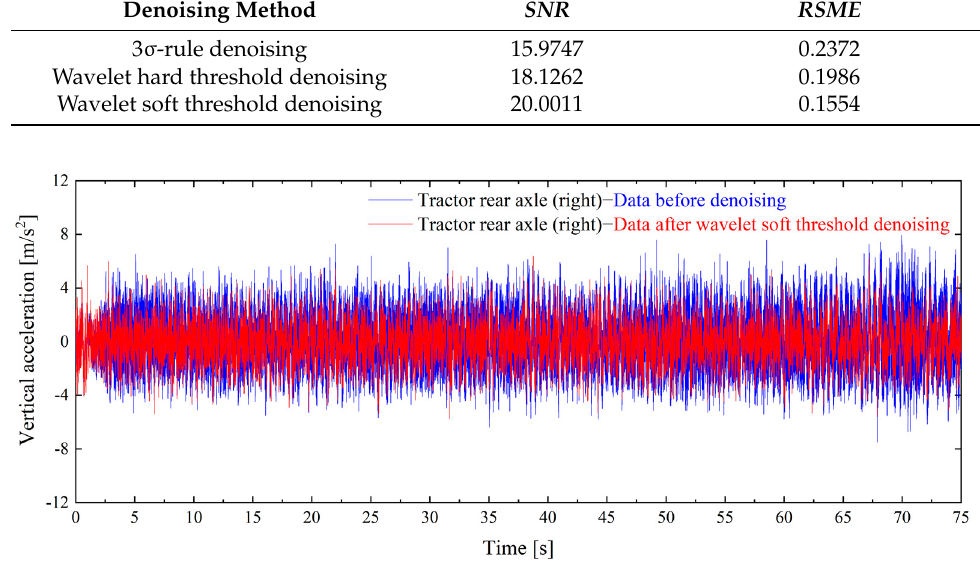
Figure 12. Comparison before and after data denoising.